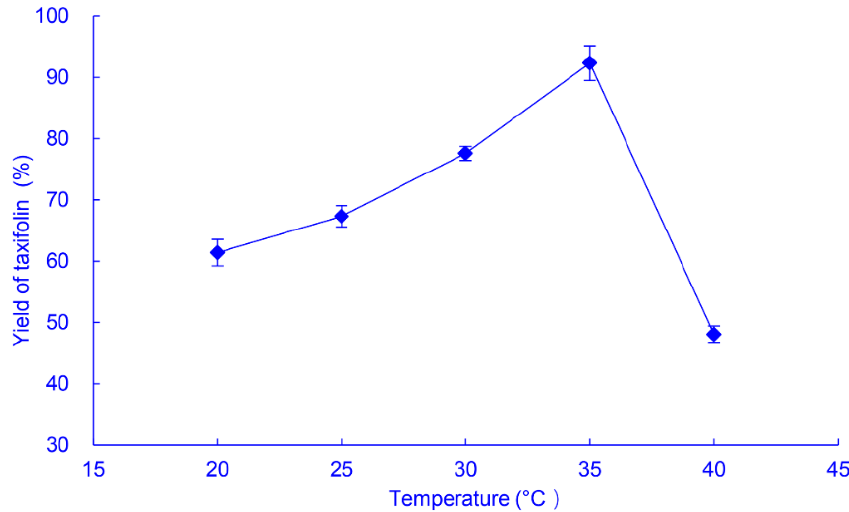
Figure 4. Effects of temperature on the yield of taxifolin from biotransformation of astilbin by A. fumigatus SQH4. Biotransformation was performed at pH 6.5 with shaking at 200 r/min for 8 h, with 1 g/L astilbin.